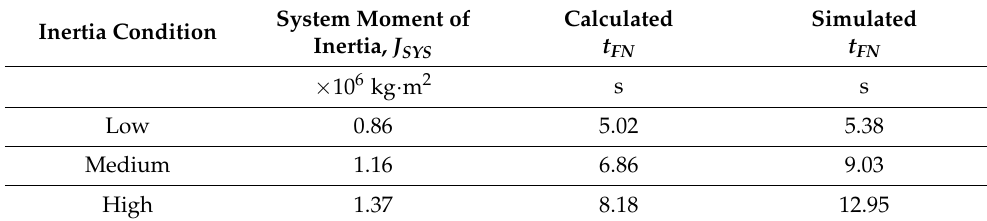
Table 1. Time until Frequency Nadir for Different Inertia Conditions.